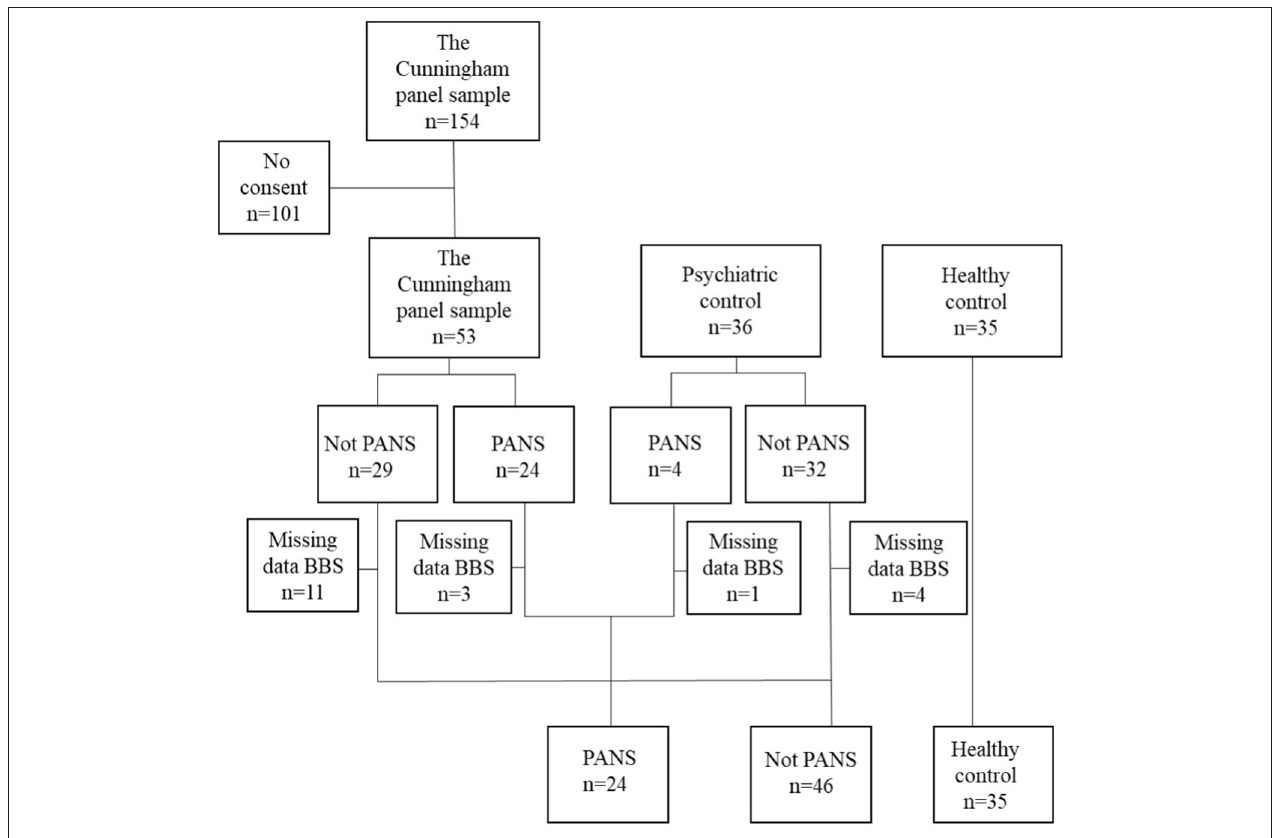
FIGURE 1 | Flowchart of study